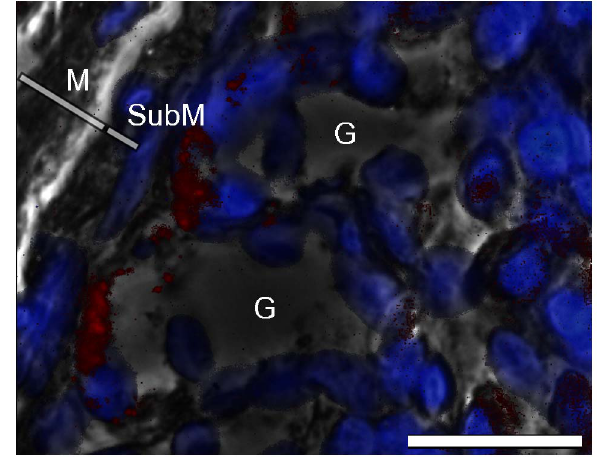
Figure 5. Immunohistochemical analysis of the stomach of Pipistrelluspipistrellus . Picture overlay of labeling of the a -AMCase antibody (red); DAPI counterstained (blue) and phase contrast demonstrating positive labeling of the antibody at the bottom of the gastric glands. Bar =50 m m. G = gastric gland, M = mucosa, SubM = submucosa.